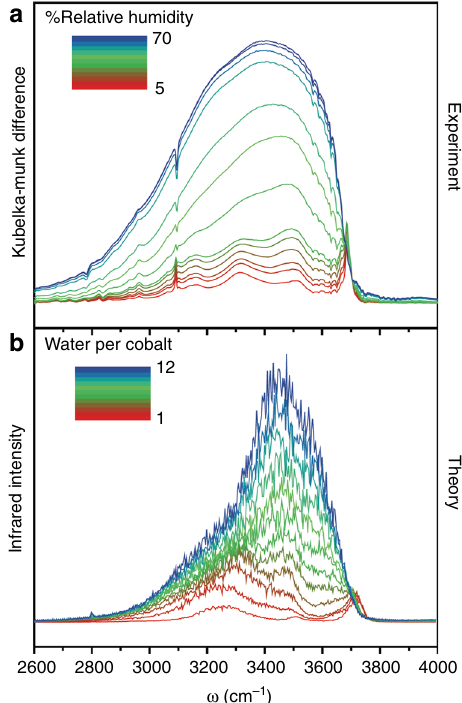
Fig. 2 Experimental and Theoretical Infrared Spectra of Water in Co 2 Cl 2 BTDD. a Difference Diffuse-Re fl ectance IR spectra of the water OH- stretch region in Co 2 Cl 2 BTDD under variable RH conditions. b Calculated IR intensity using the MB-pol model of water in Co 2 Cl 2 BTDD ranging from one water molecule per cobalt (1) to twelve water molecules per cobalt